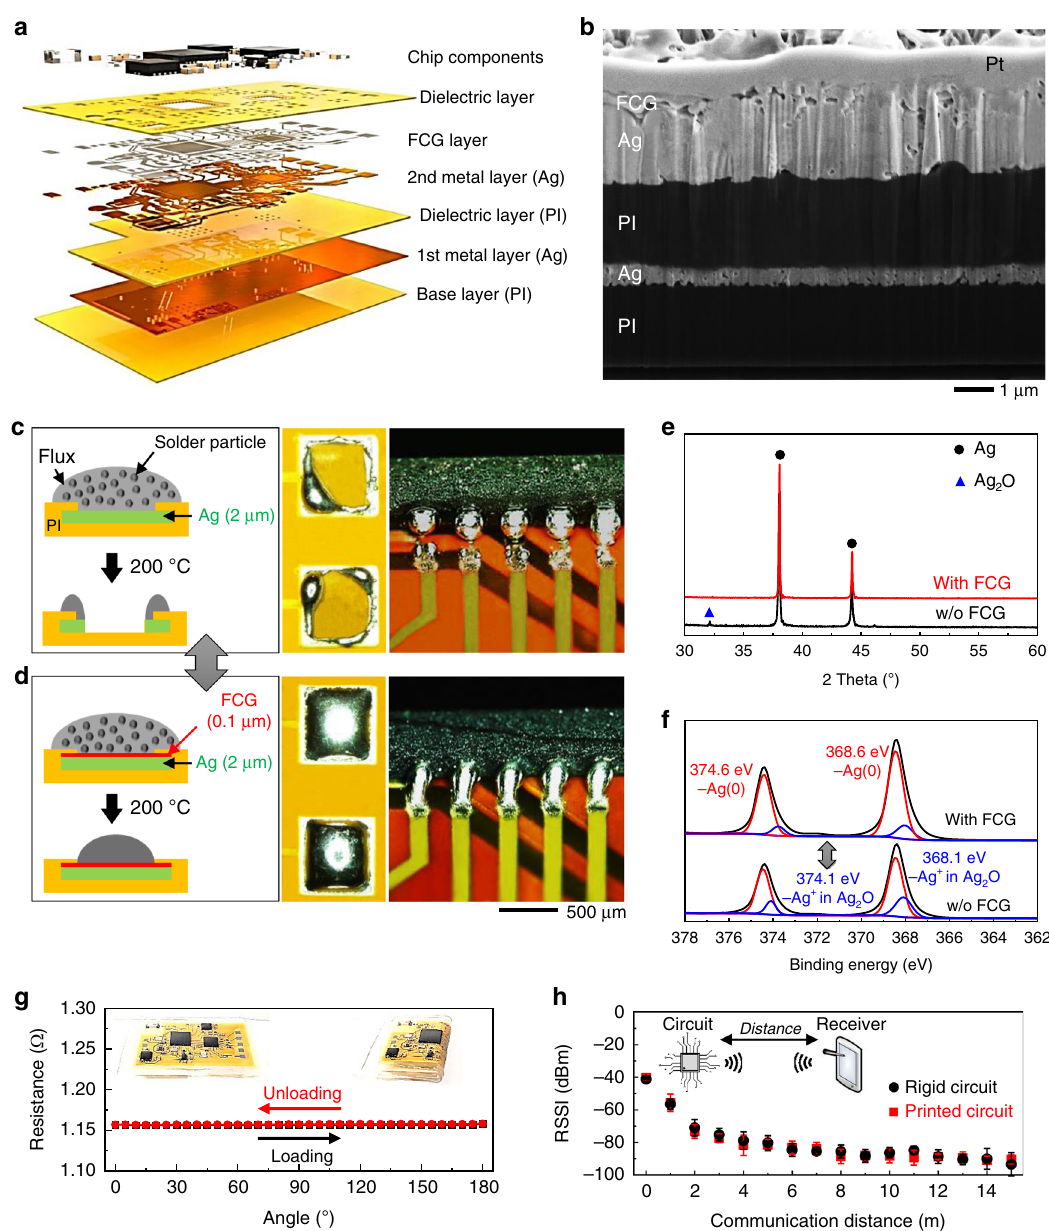
Fig. 3 Printing, integration, and characterization of a multilayered electronic circuit. a Schematic illustration that captures the multilayered, printed, fl exible, wireless electronics. b FIB-assisted SEM image showing the cross-section of a printed multilayered circuit that follows the illustration in a ; Pt is deposited on top of the circuit to protect the circuit structure during preparation for a cross-section imaging. c , d Comparison of solderability between two materials. Schematic illustration (left side on c , d ) shows two different circuits with Ag layer only ( c ) and FCG (thickness: 0.1 µ m) on top of Ag layer ( d ), which captures the capability of FCG to block the consumption of the Ag layer due to the solder fl ux. Corresponding photos (middle and right) clearly show the difference between two cases; without FCG, the Ag-based contact pad is removed during the re fl ow step. e , f Characterization results with XRD ( e ) and XPS ( f ) of sintered Ag with and without the printed FCG. XRD data ( e ) capture the anti-oxidation effect of printed FCG, while XPS data ( f ) show the FCG/ Ag membrane is only diffracted at the peaks of 38.0°, 44.1°, and 54.8°, indicating the pure Ag structure without oxidized Ag. g Change of electrical resistance of a highly fl exible printed circuit upon 180° bending (up to 100 cycles), showing negligible change in resistance. Inset photos show the tested circuit wrapped around a curved glass edge up to 180°. h Simultaneous comparison of RSSI response between a commercial rigid circuit and printed circuit, showing a comparable performance of the printed circuit with the communication distance up to 20 m based on (Fig. 3a). The cross-sectional SEM image in Fig. 3b captures the processing condition optimization. Sequential SEM images in uniformity of the layer-by-layer structure with great packing Supplementary Fig. 13 show the structural change from as- density around one of the conductive pads to be connected with printed Ag nanoparticles to a densely-packed Ag membrane for a chips. This image also shows the capability of the AJP method to conductive fi lm. allow reliable deposition of multiple materials sequentially. In the For the development of a wireless electrophysiological monitor, circuit, the conductive Ag traces were photonically sintered via a a set of miniaturized functional chips were utilized, including